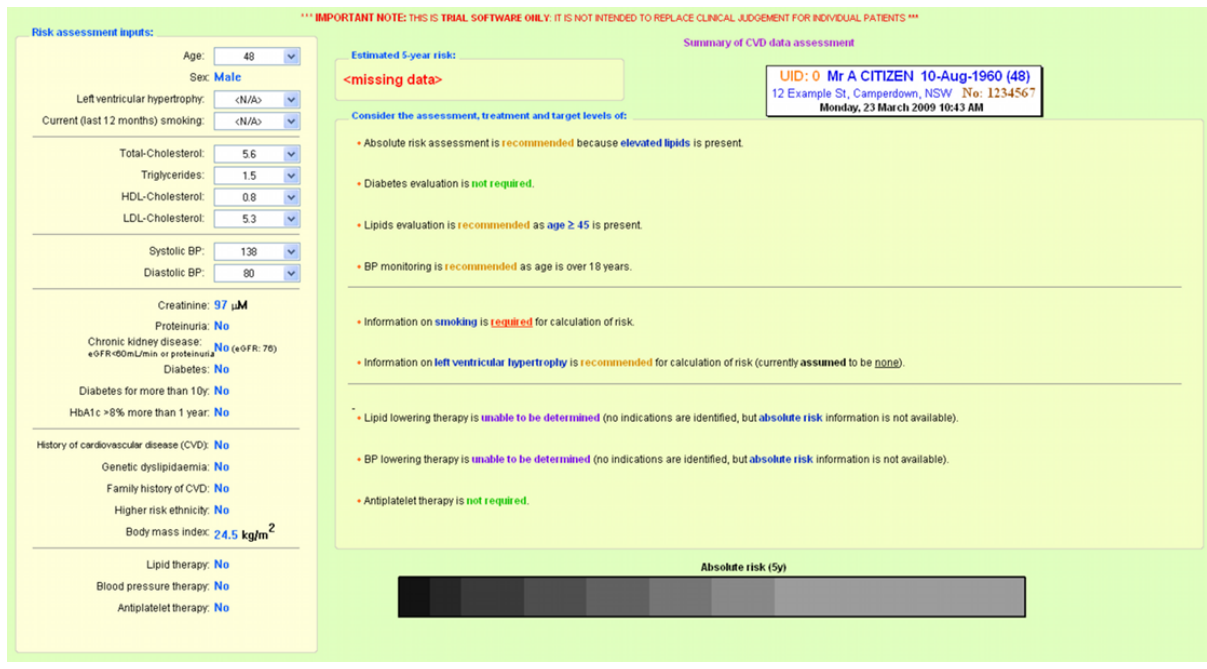
Figure 2. Sample CDS output with incomplete information and greyscale